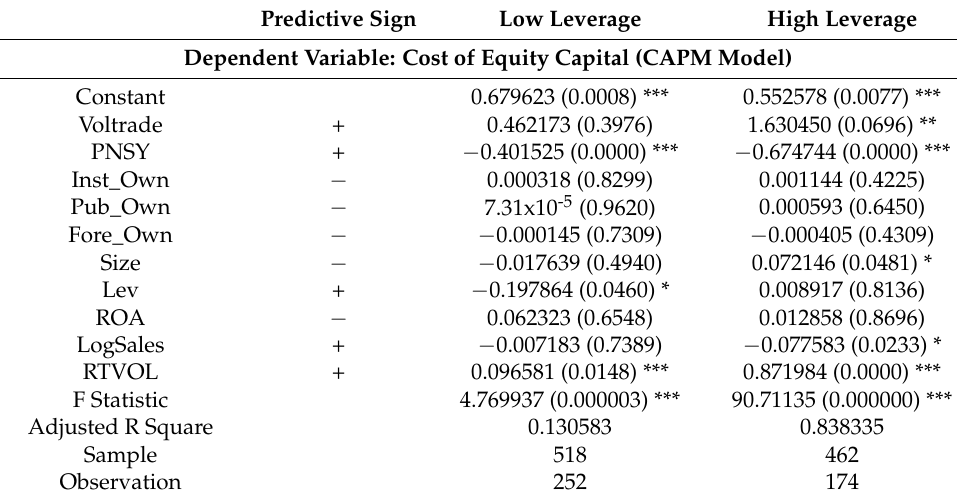
Table 8. Additional tests based on the leverage